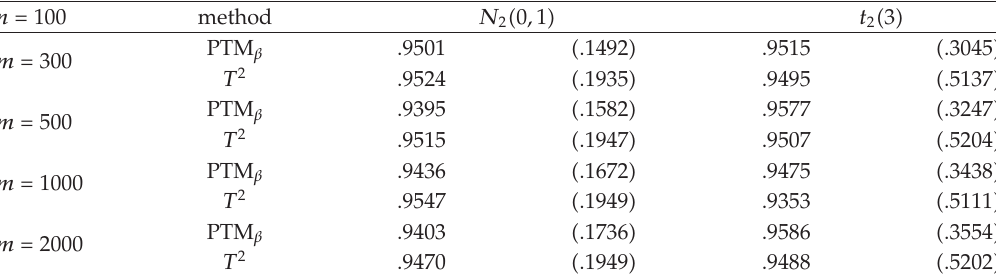
Table 3: Average coverage (cid:2) length (cid:3) of 95% confidence regions by T 2 and PTM β